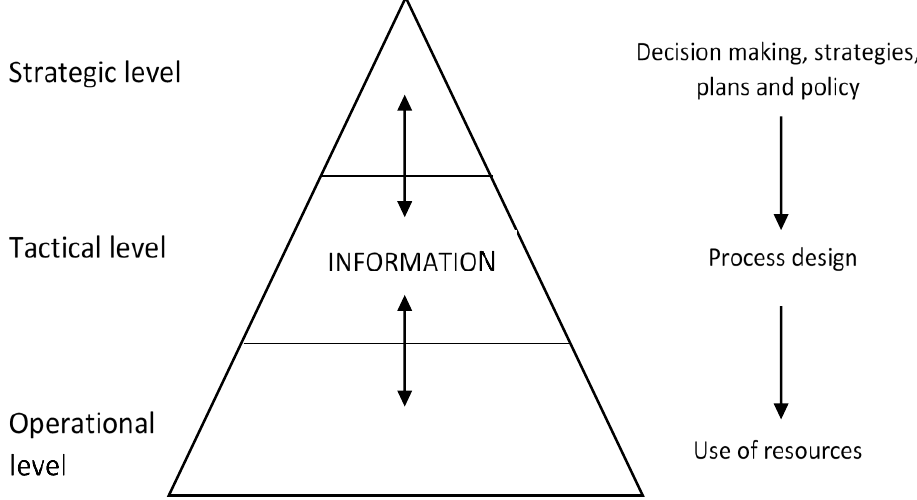
Figure 1. A three-level management model, developed by the authors.